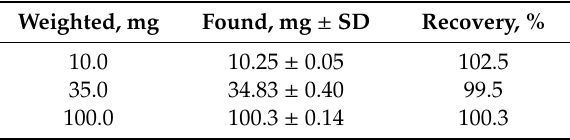
Table 5. Determination of mCPP in pure samples using CE • NaTPB / KTpClPB polymeric membrane based